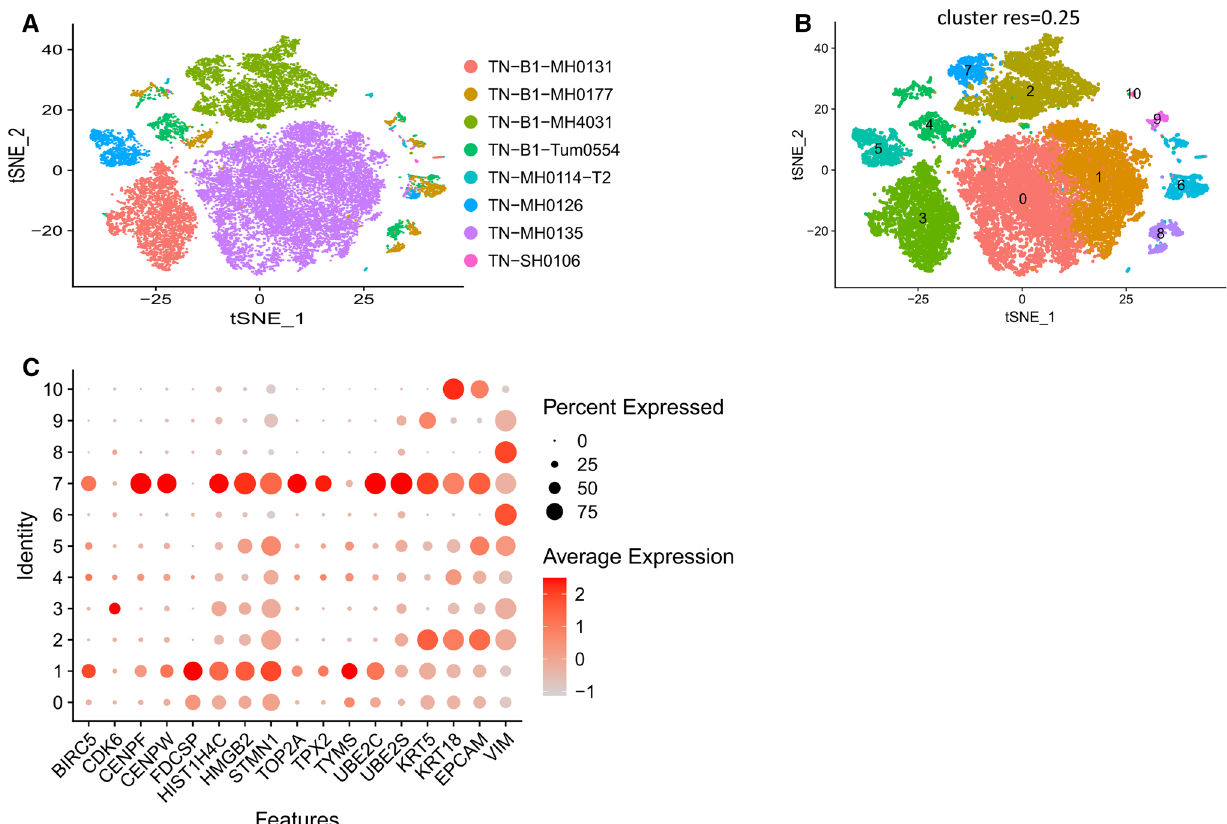
Fig. 4 SC gene expression in eight human triple-negative breast cancer cell datasets. A t-SNE plot of eight triple-negative breast scRNA-seq datasets. Individual dots correspond to cells and dot color indicates individual tissue sample. B The cells from the t-SNE plot of A was broken down into eleven cell clusters at 0.25 cluster resolution based on shared gene expression patterns. The dot color and number represent cell clusters. C Dot plot showing the expression of SC genes in the breast cancer cell populations, as well as a basal (KRT5), luminal (KRT18), epi- thelial (EPCAM), and mesenchymal (VIM)